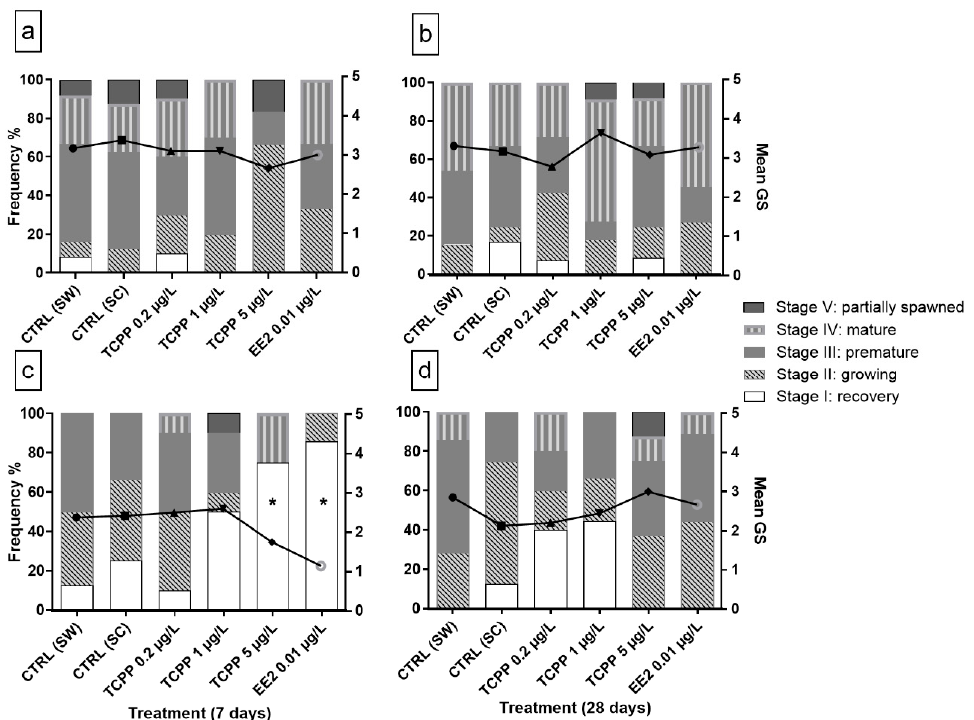
Figure 2. Relative frequencies of the gametogenic stages in histological sections of female ( a , b ) and male ( c , d ) P. lividus sea urchins exposed for 7 ( a , c ) and 28 ( b , d ) days in 2017 (n = 4 to 14). The black line is the weighted average of the gametogenic stage (GS) for each treatment (Table S1). Asterisks indicate significant ( P < 0.05) differences with respect to solvent control (CTRL (SC)).